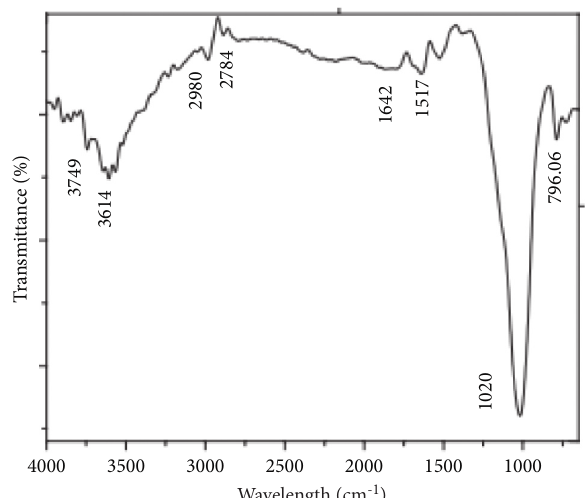
2 /zeolite, and 10%Cr/TiO 2 / Figure 10: FT-IR spectra of the natural zeolite clinoptilolite type adopted from